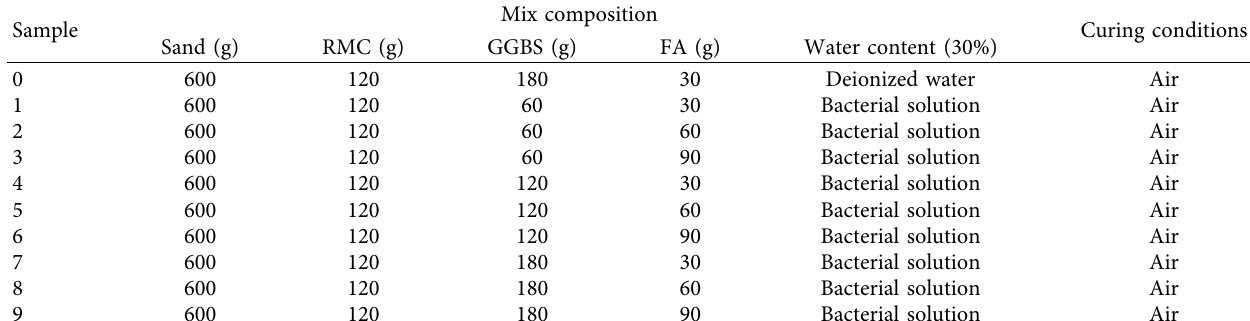
Figure 3: XRD pattern of GBS and FA Table 2: Mixture formulations prepared under this study.